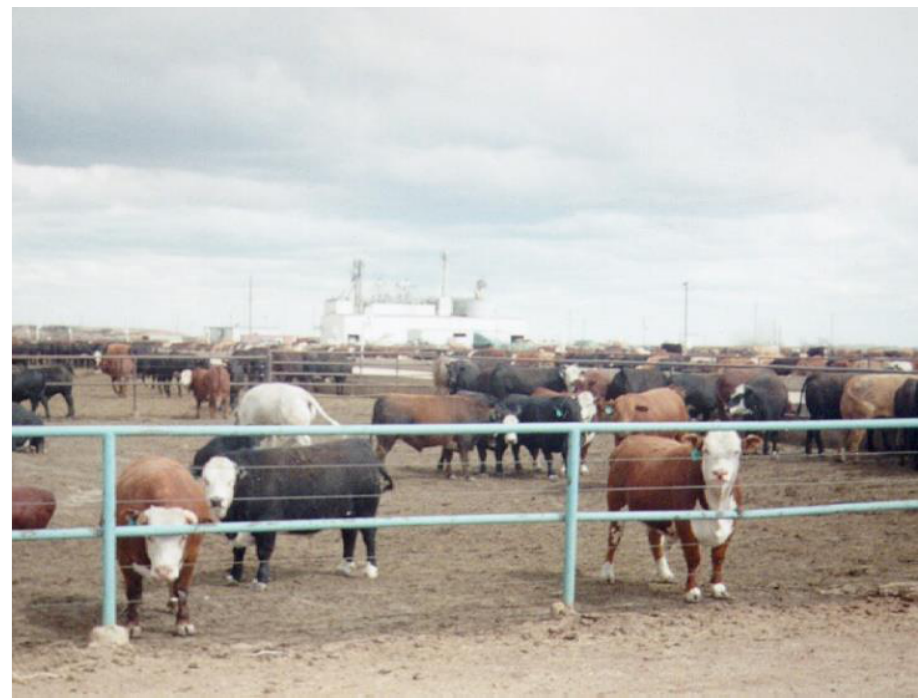
Figure 1. Commercial feedyard in the Texas Panhandle. Cattle are kept in soil – surfaced pens at a density of ~15 m 2 · animal − 1 for 150 to 180 days. Manure accumulates until cattle are removed for slaughter. The pens develop wet / muddy areas, dry areas, and areas with high urine / feces where cattle congregate. The underlying manure forms a dense “pack” that generally contains more H 2 O than surface manure.